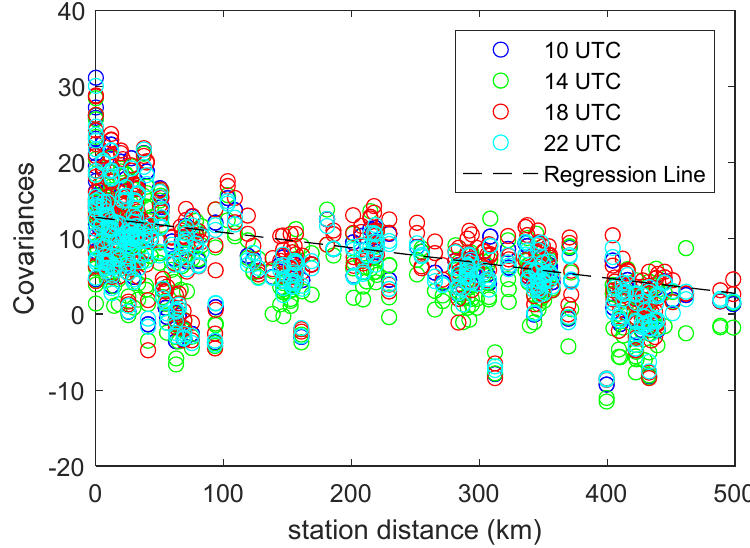
Figure 2. Covariogram, representing covariance as a function of hour. Although the covariogram was calculated for all 24 h, every fourth hour was plotted for clarity.